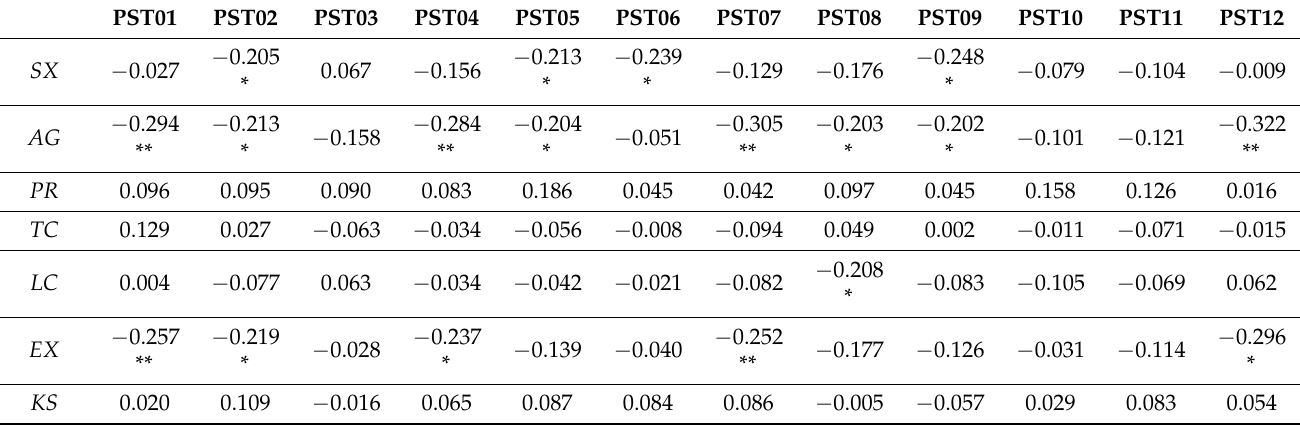
Table A7. Spearman correlation matrix: use of problem solving tools.